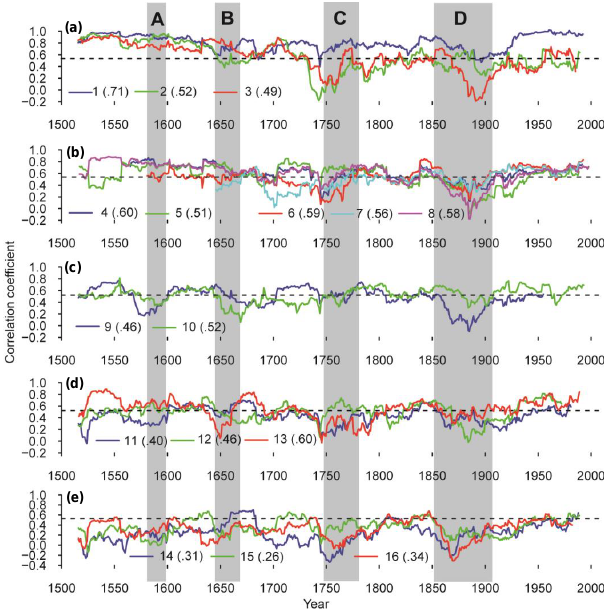
Figure 9. Running 31-year correlation coefficients between GHD- based reconstructed Czech AMJJA temperatures and selected Euro- pean proxy reconstructions. (a) Documentary: (1) AMJJA Central Europe (Dobrovolný et al., 2010); (2) JJA central Europe (Luter- bacher et al., 2004); (3) summer Low Countries (van Engelen et al., 2001). (b) Grape-harvest dates: (4) AMJJA Swiss Plateau (Meier et al., 2007); (5) AMJJA Burgundy (Chuine et al., 2004); (6) MJJ Vienna and Klosterneuburg region (Maurer et al., 2009); (7) MJJ Közseg, Hungary (Kiss et al., 2011); (8) AMJJ Switzerland (Wet- ter and Pfister, 2013). (c) Grain-harvest dates: (9) MAMJJ northern Switzerland and southwestern Germany (Wetter and Pfister, 2011); (10) MAMJJ Czech Lands (Možný et al., 2012). (d) Multiproxies: (11) JJA European Alps (Trachsel et al., 2012); (12) AMJJAS west- ern Europe (Guiot et al., 2005); (13) JJA Europe (Luterbacher et al., 2016). (e) Tree rings: (14) JJA western and central Europe (Büntgen et al., 2011); (15) JJAS Alps (Büntgen et al., 2006); (16) JJ central- eastern Alps (Wilson and Topham, 2004). Numbers in brackets are overall correlations for the common period in question. Broken hor- izontal lines represent critical values of correlation coefficient esti- mated using Monte Carlo simulation to oversee the effect of mul- tiple comparisons and approximate 95% confidence level for one- tailed test. Vertical columns A–D identify periods in which GHDs might have been influenced by the social and political processes discussed in the text: A – series of bad grape yields; B – the Thirty Years’ War; C – the War of the Austrian Succession and the Seven Years’ War; D – series of bad grape